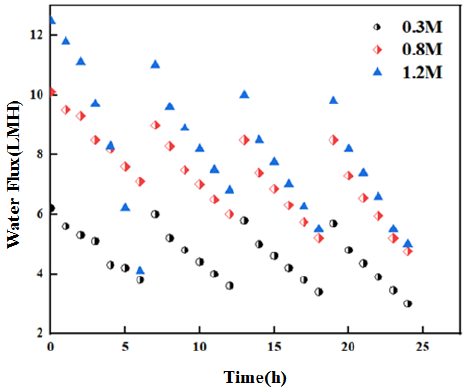
Figure 1. Change in membrane flux during operation of